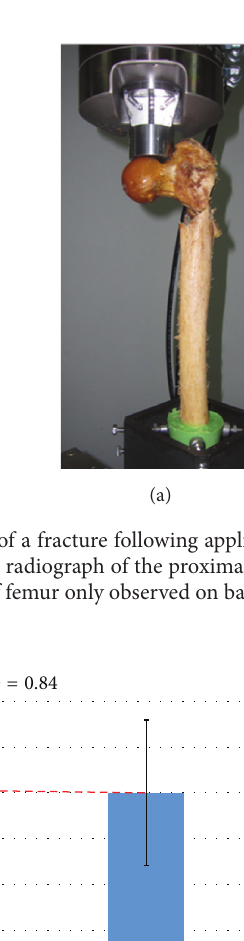
Figure 2: (a) Clinical photography of a fracture following application of a static axial compressive load to a femur from which a PFNA-II had been removed. (b) Anteroposterior radiograph of the proximal femur following PFNA-II removal revealing an intertrochanteric fracture.